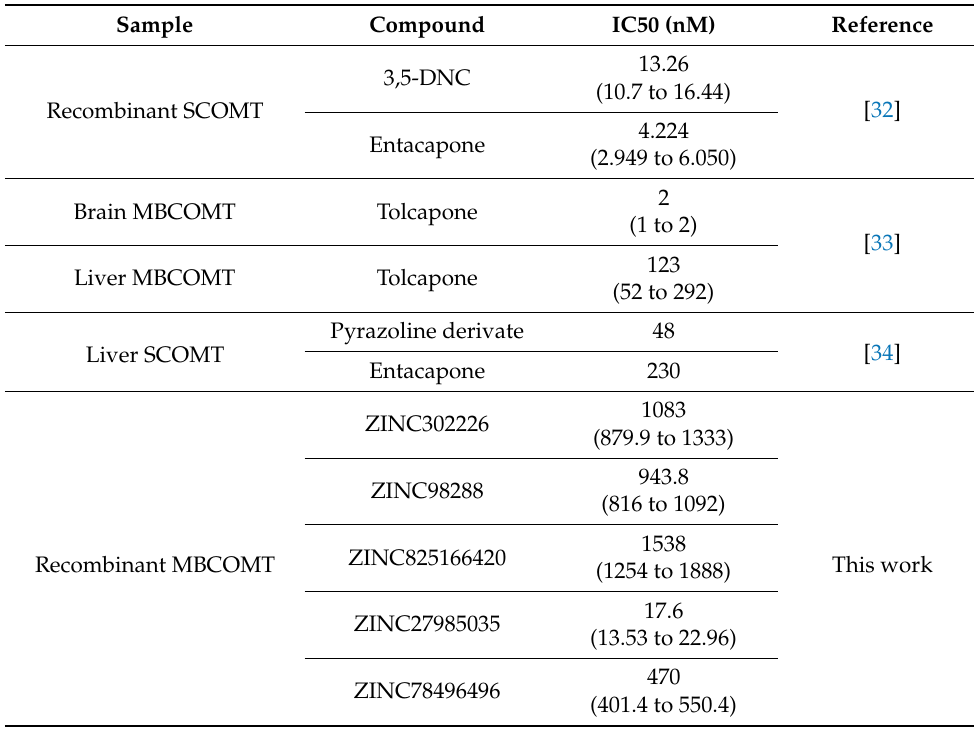
Table 3. Estimated IC 50 values (nM) for selected compounds with MBCOMT performed in this work in comparison with previous ones reported in the literature. Values are means with 95% confidence ( n = 2 to 3).